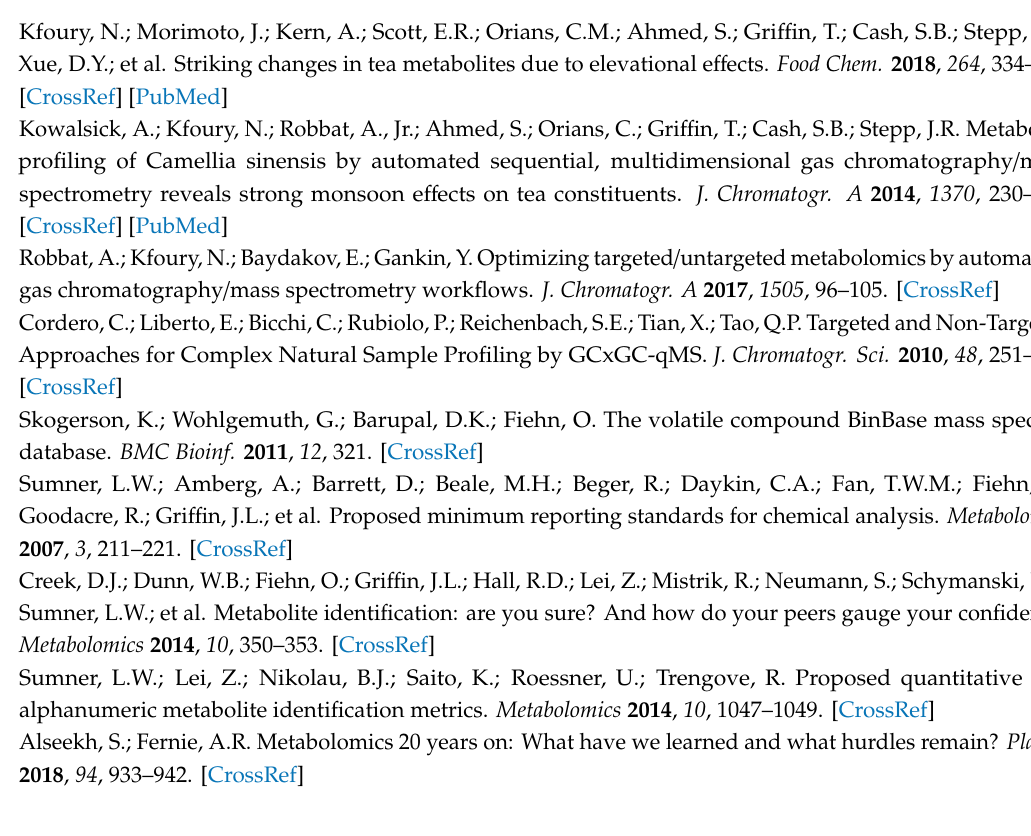
Supplementary Materials: The following are available online, Figure S1: Ion Analytics and GC Image workflow schematic for the analysis of targeted and untargeted compounds, Table S1: Features detected by GC Image and confirmatory analysis, Table S2: Compounds identified by Ion Analytics. The unprocessed GC × GC / MS data can be found at: http: // dx.doi.org / 10.25833 /